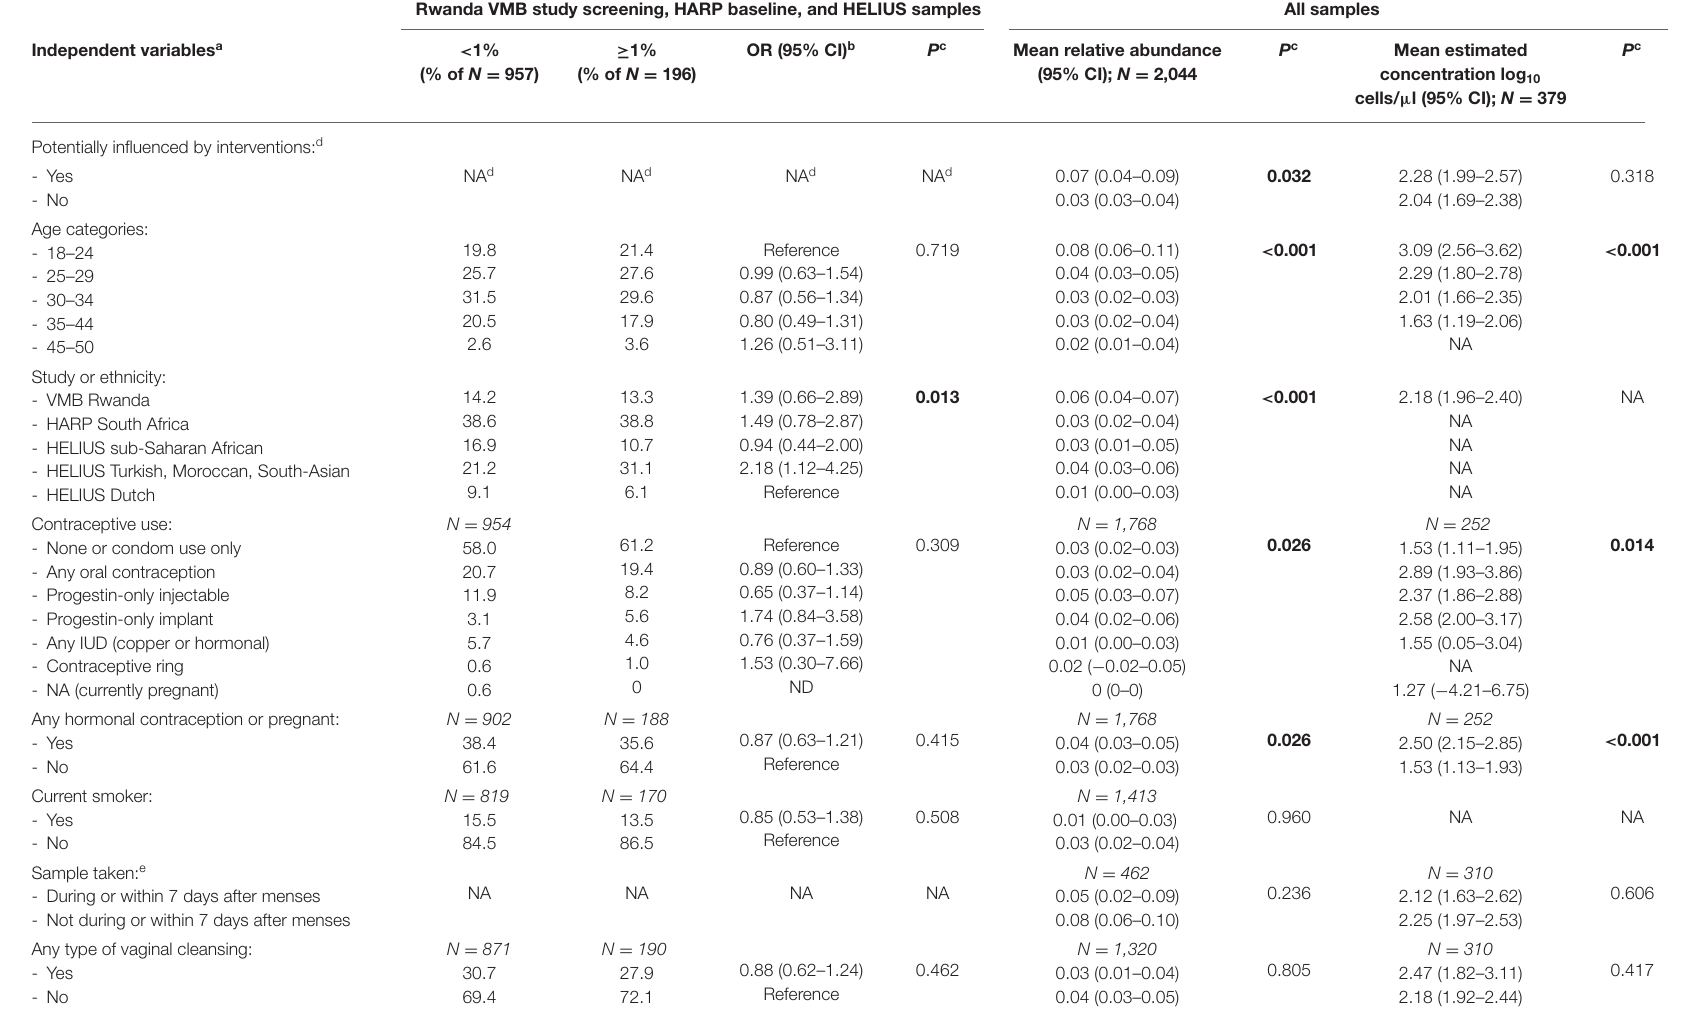
TABLE 6 | Correlates of pathobionts detection, relative abundance, and estimated concentration. Rwanda VMB study screening, HARP baseline, and HELIUS samples All samples Independent variables